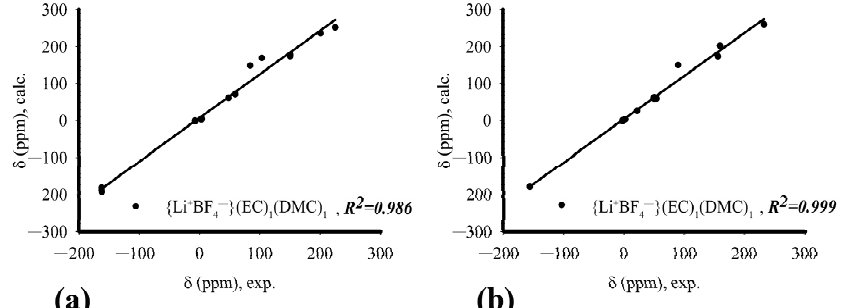
Figure 7. Dependence of experimental and calculated values of chemical shifts : ( a ) {Li + BF 4 − }(EC) 1 (DMC) 1 ; ( b ) {Li + BF 4 − }(SL) 1 (DMC) 1 . ( b ) {Li + BF 4 − }(SL) 1 (DMC) 1